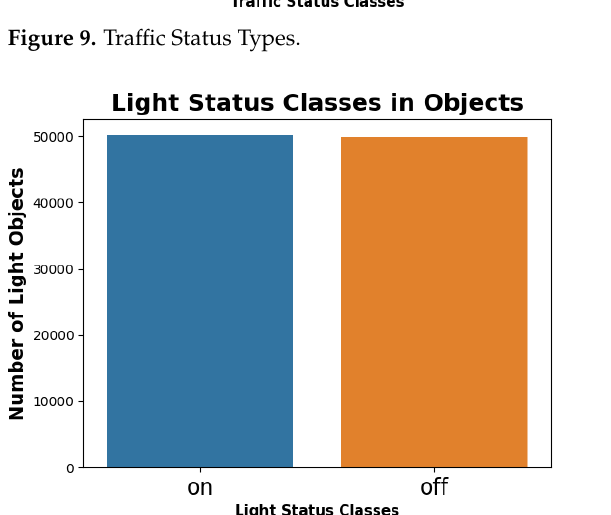
Figure 10. Street Light Status